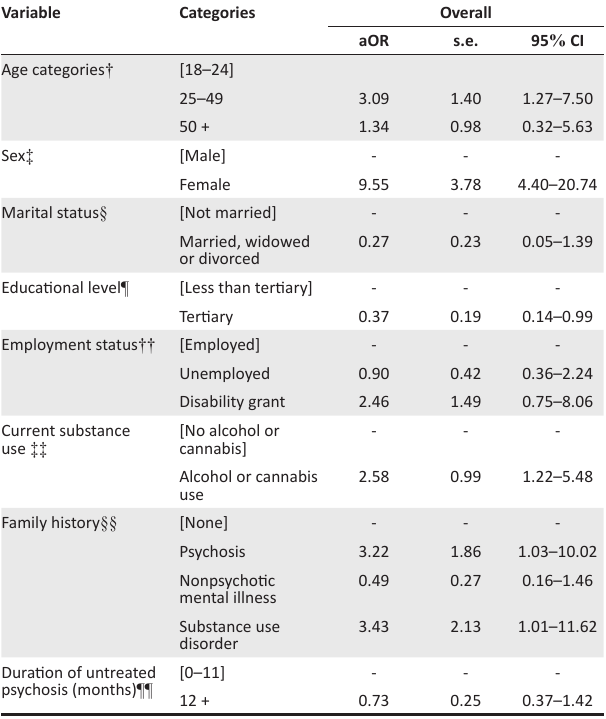
TABLE 2: Association between HIV status and sociodemographic and clinical characteristics in people with recent-onset psychosis. Variable